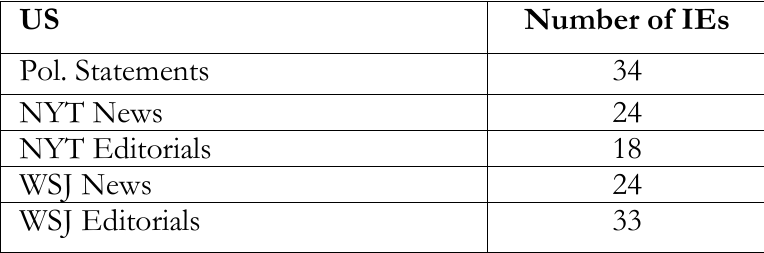
Table 1. Framing samples in the US political statements and media coverage